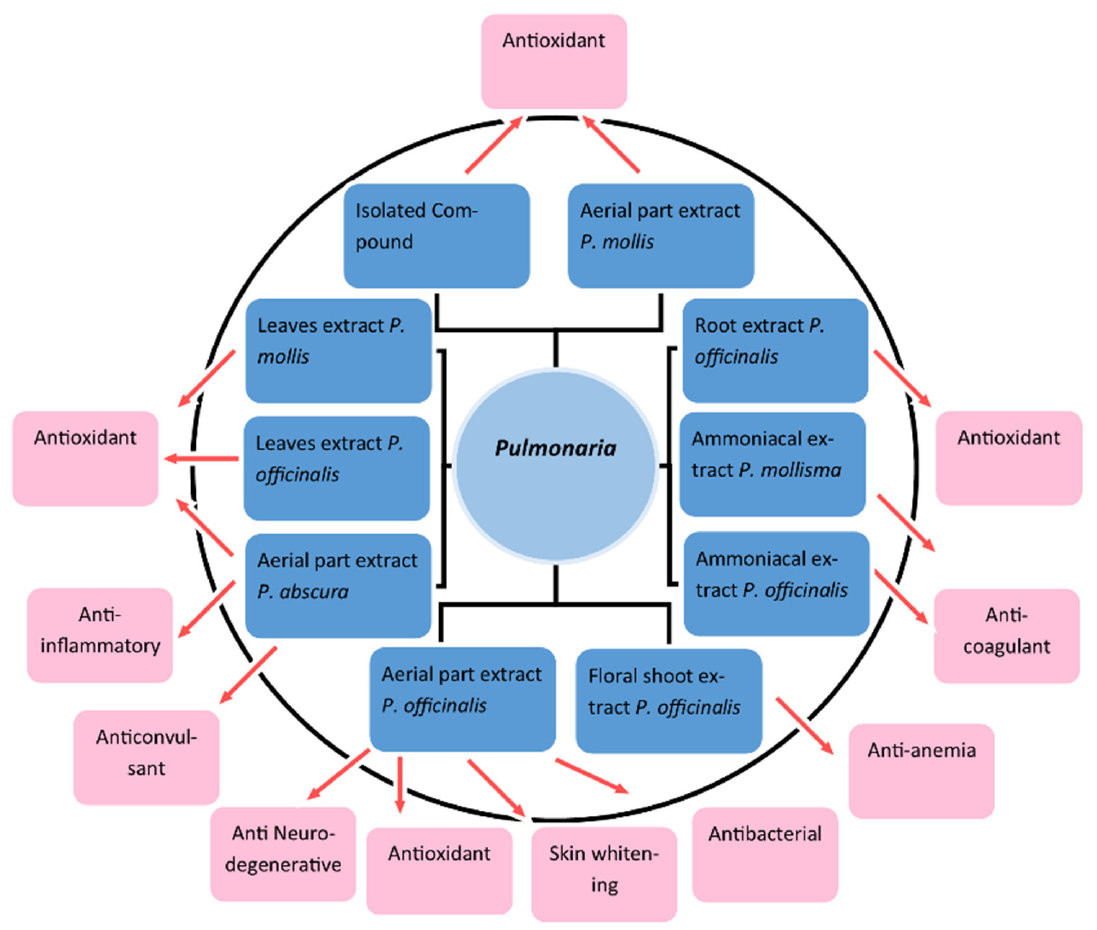
Figure 3. Biological activities of lungwort reported from different parts of the plant.